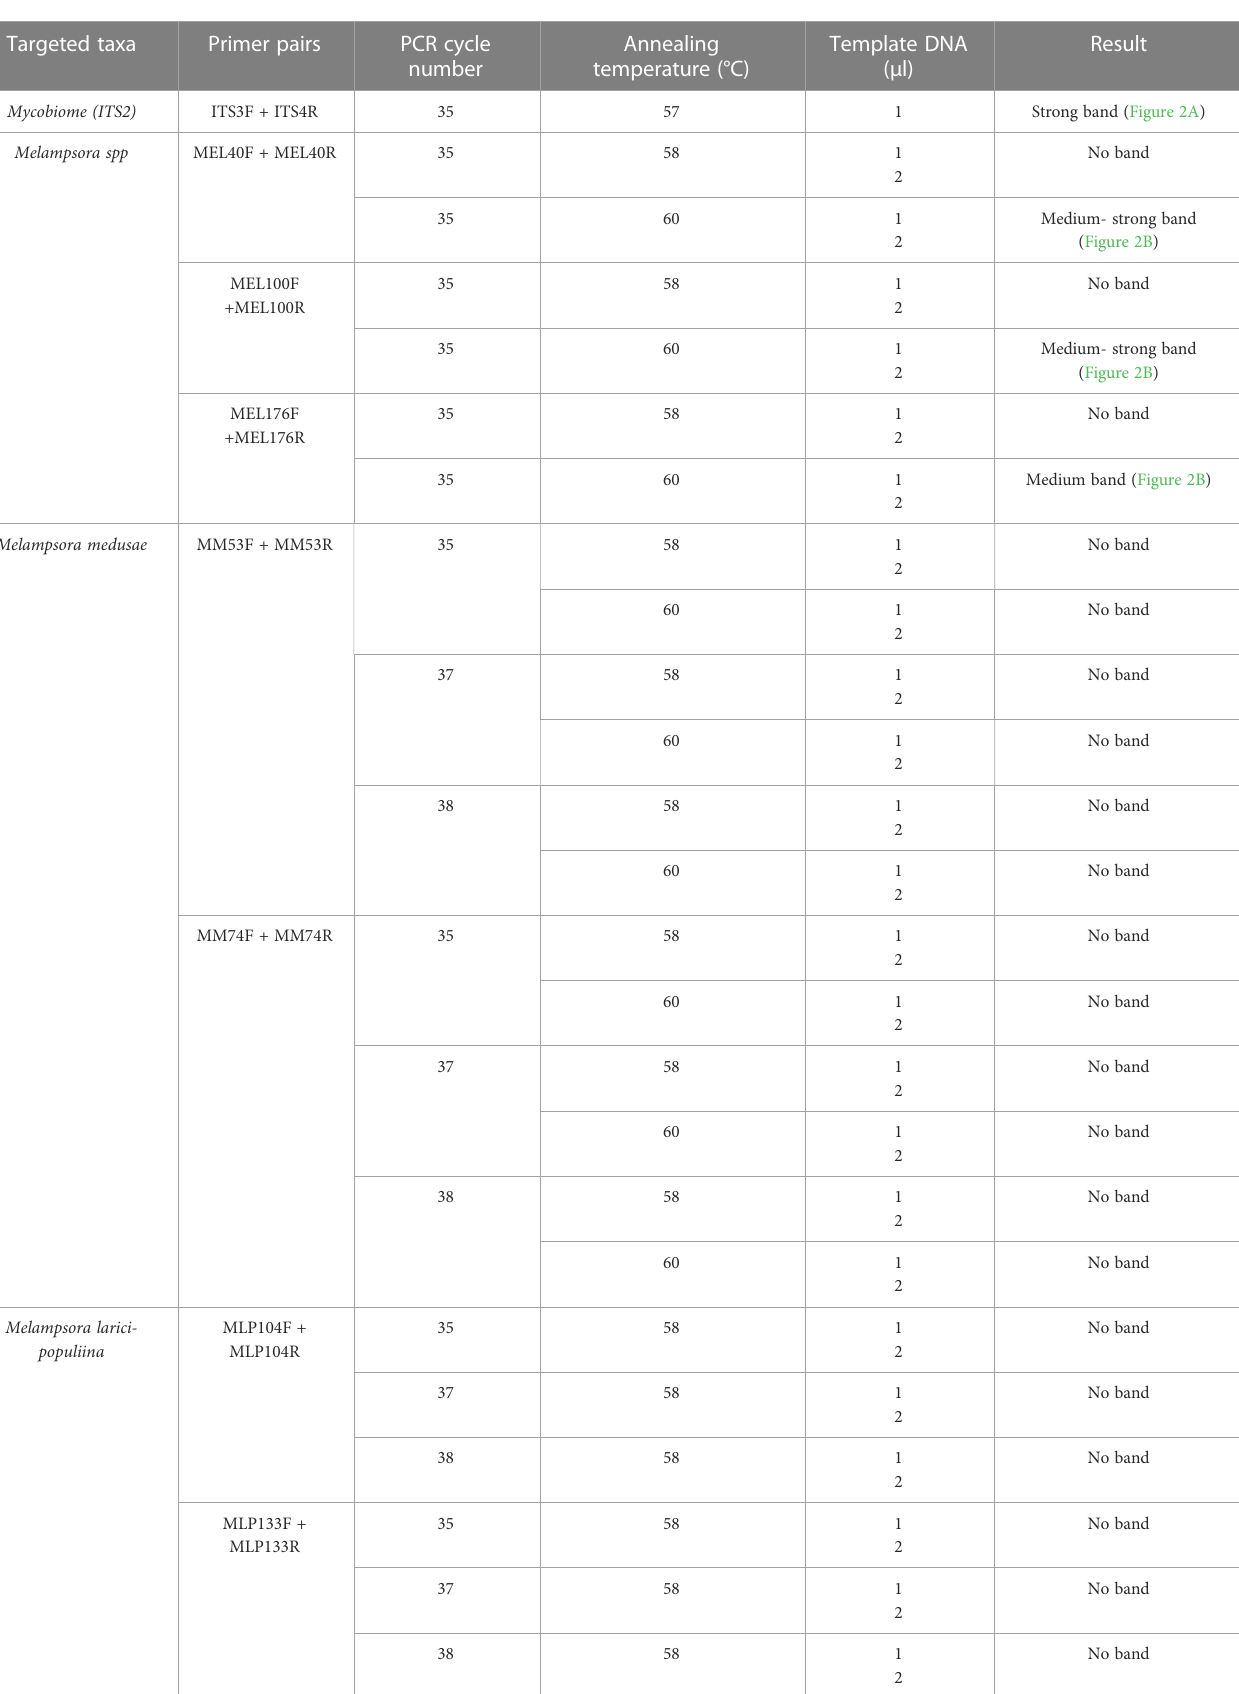
TABLE 2 Results of PCR ampli fi cations of DNA originating from microbial fungi in leaves from six aspen genotypes grown in the TanAsp common garden in Vindeln, Sweden. Targeted